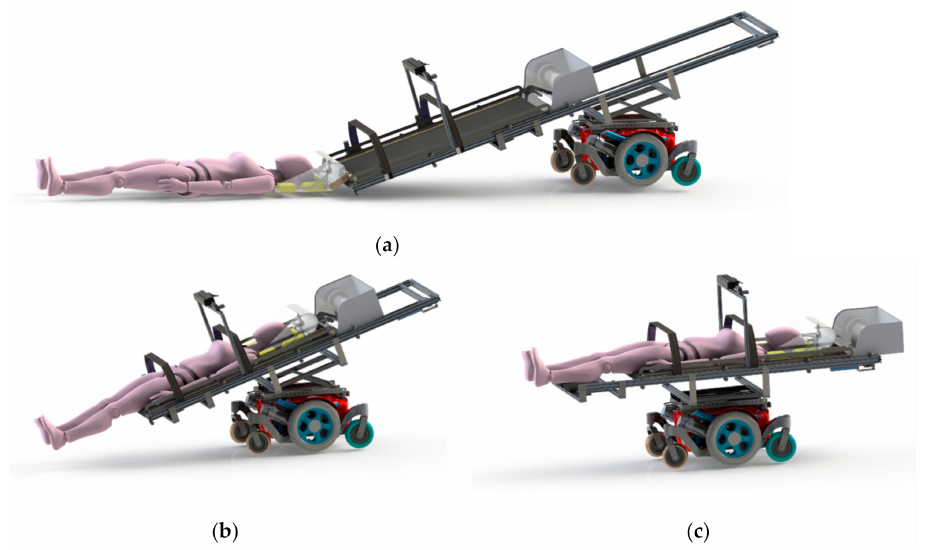
Figure 13. Sequential snapshots ( a – c ) of ResQbot 2.0 carrying out a simulated casualty extraction, as proposed in Section